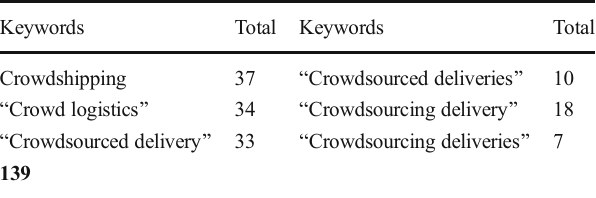
Literature selection keywords and findings (2 February